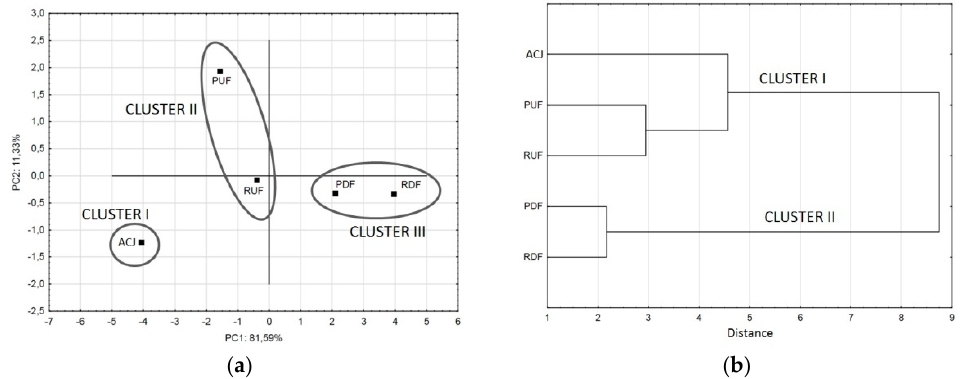
Figure 6. Principal component score plot of the effect of the first two discriminant functions in the classification of different samples considered ( a ), and dendrogram obtained by hierarchical cluster analysis ( b ).